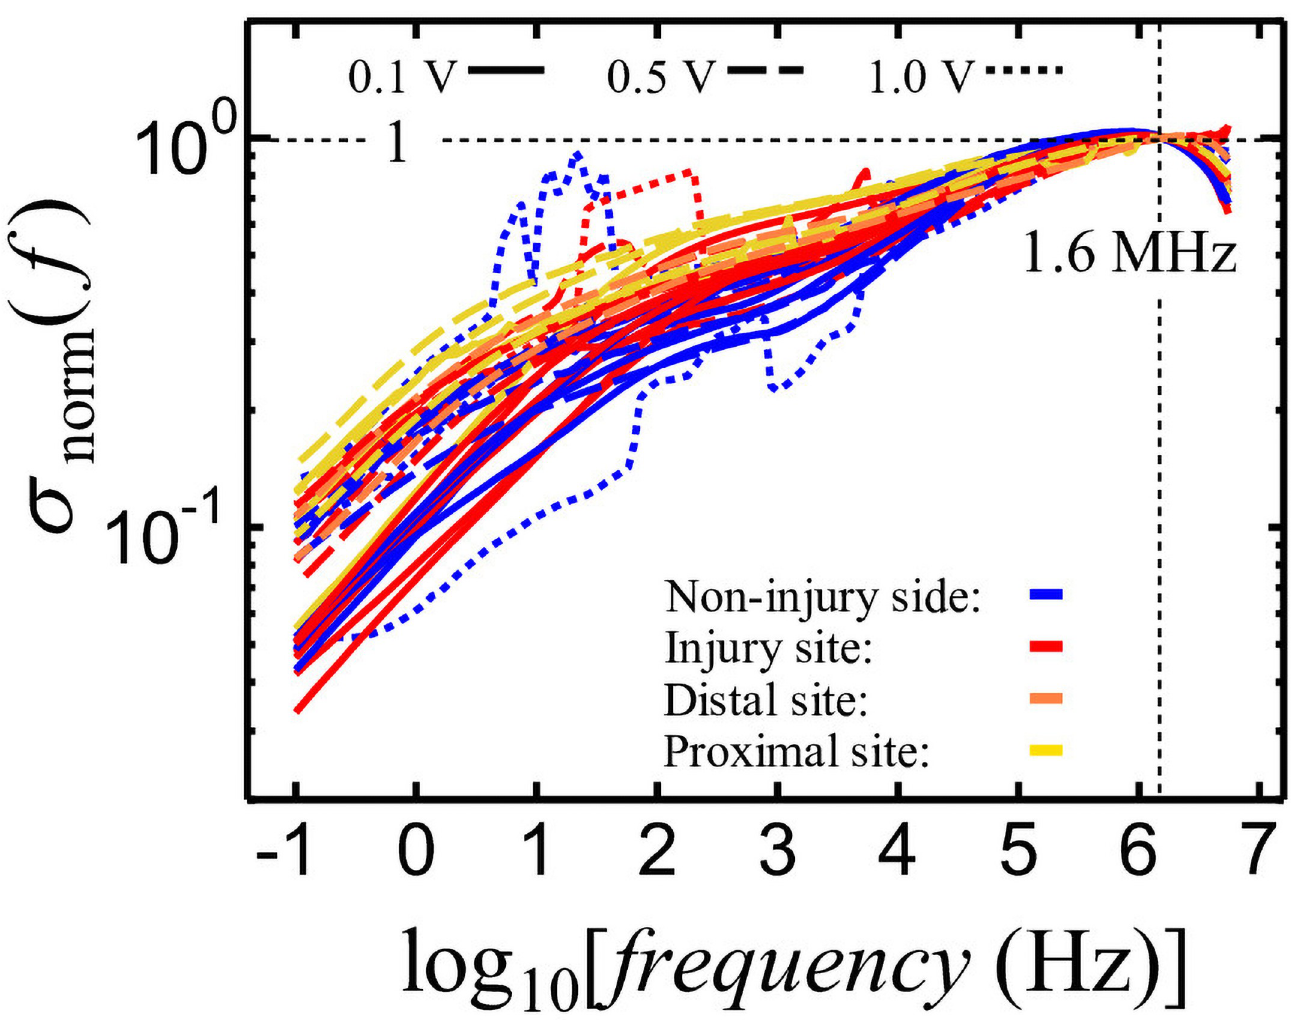
Fig 8. Frequency dependence of nerve σ normalized by σ ( f = 1.6